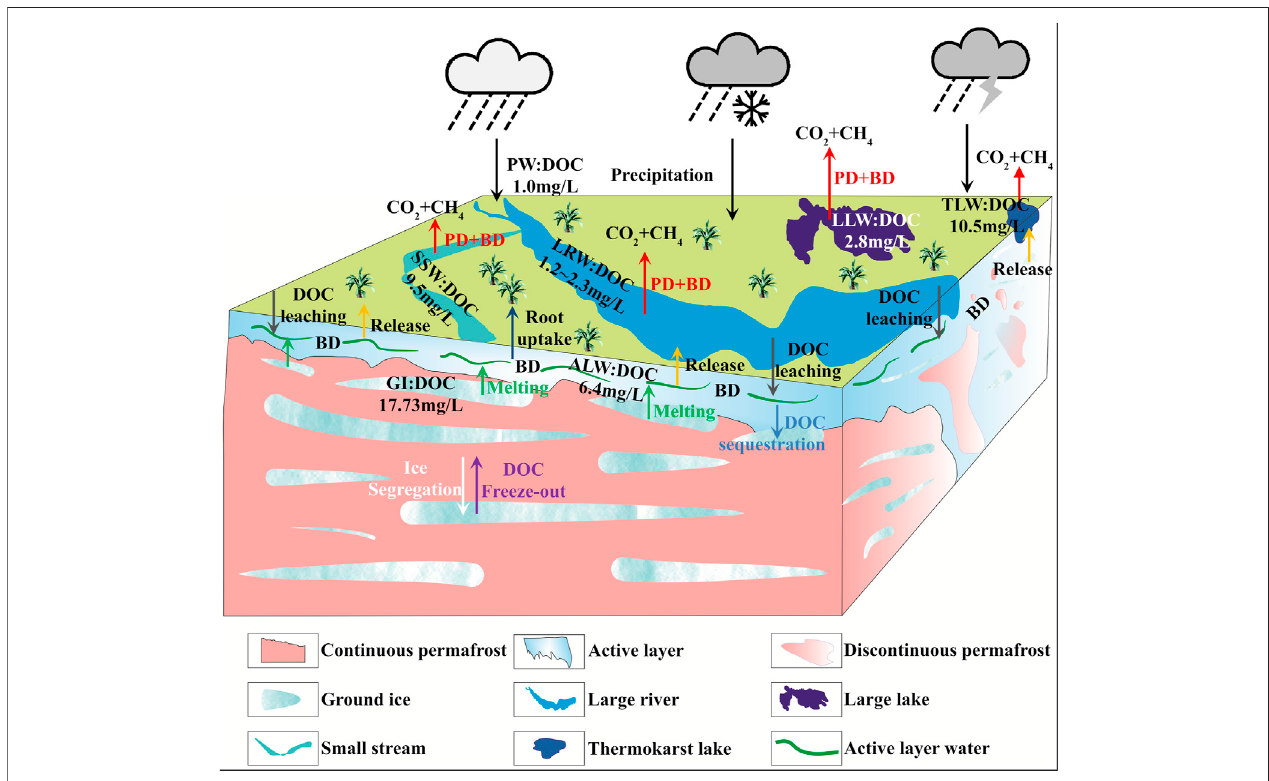
FIGURE 9 | Conceptual diagram of DOC dynamics under permafrost thaw in the SAYR. BD and PD stand for biochemical degradation and photo degradation.